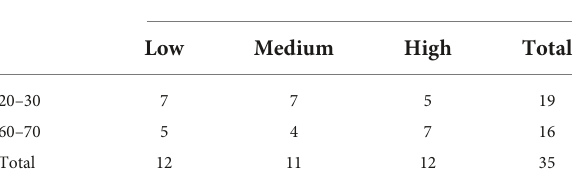
TABLE 5 Frequency distributions of α 3/2 power ratio tertiles by age